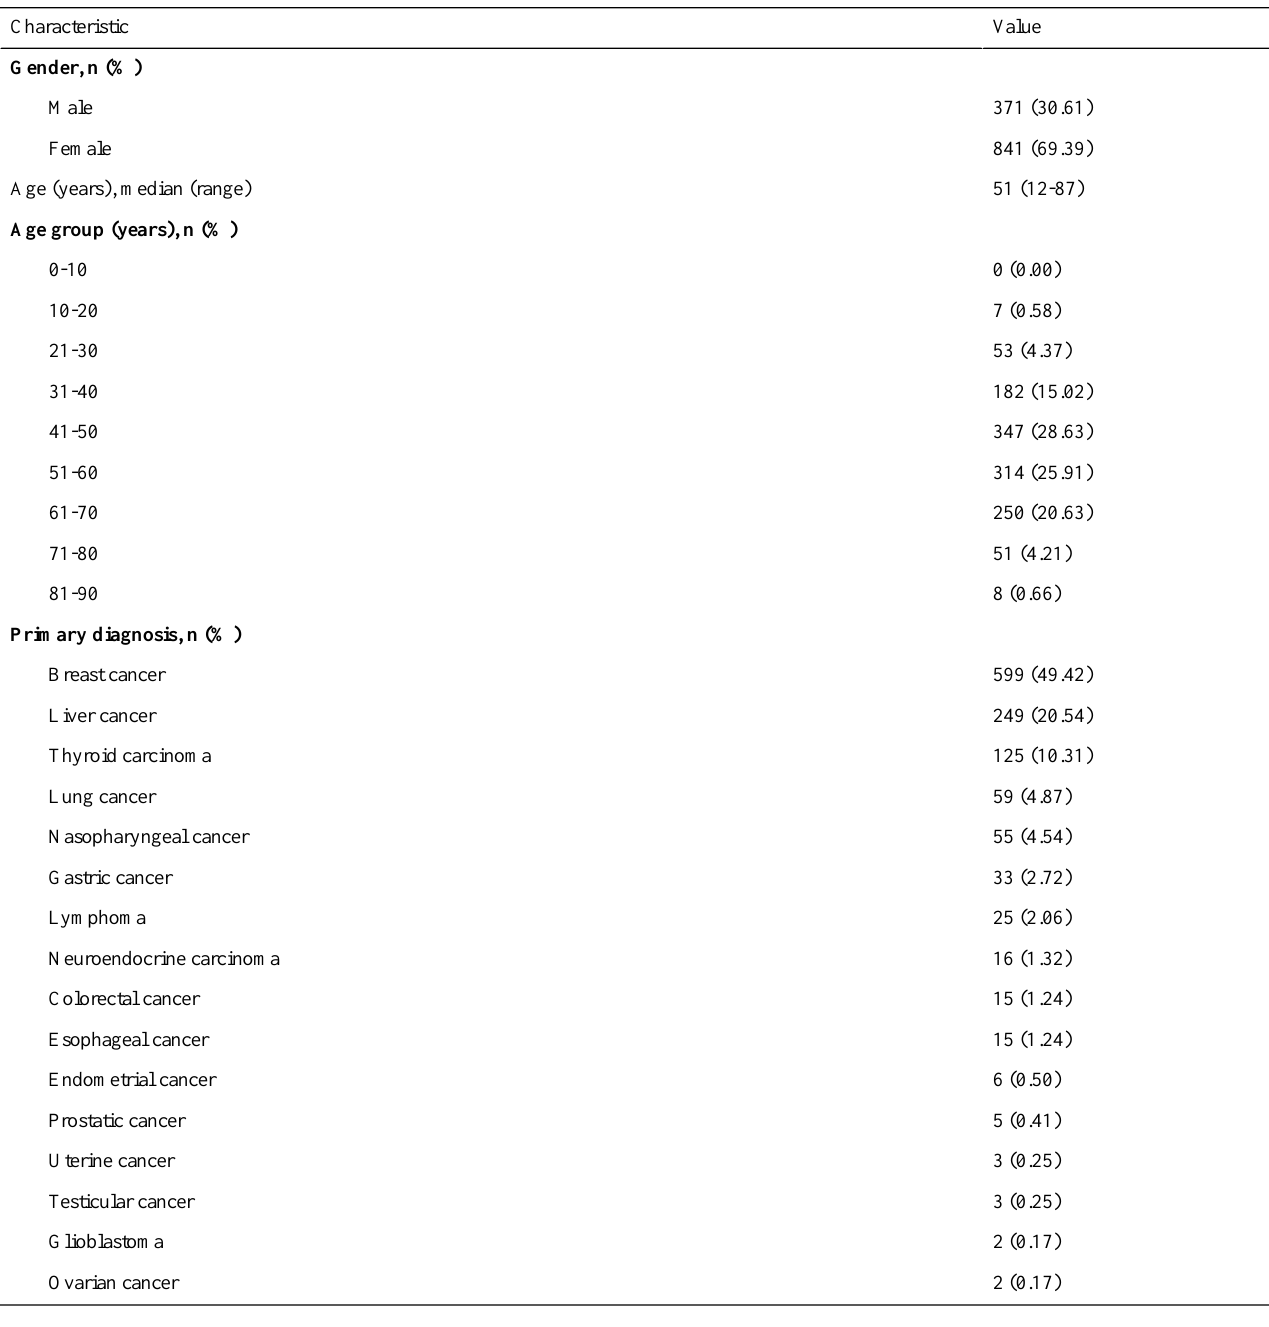
Table 2. Characteristics of patients who received online prescriptions from the Cloud SYSUCC app